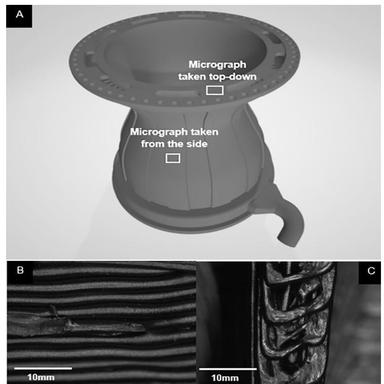
The locations of the micrographs taken of the optimised layer resolution (A) schematic of the combustion chamber (B) side view showing the deposition of layer striations and (C) top down view of a 10 mm width section showing the formation of the outer shell and infill structure.